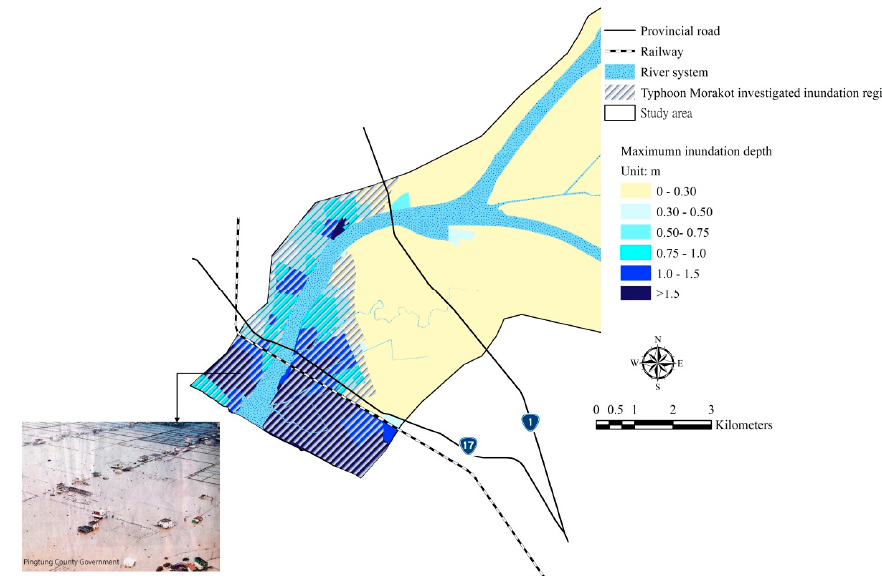
Figure 6. Investigated and simulated inundation depth for Typhoon Morakot.